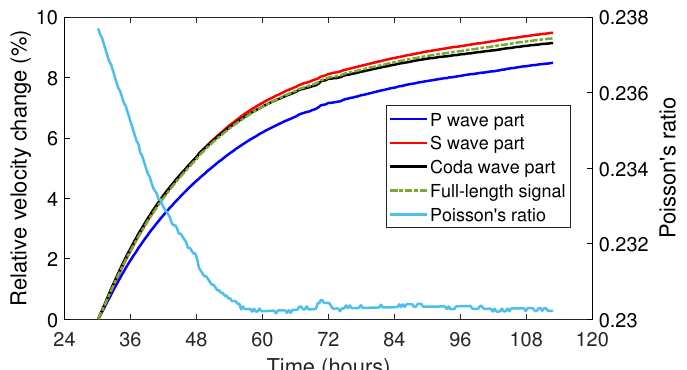
Figure 6. Relative wave velocity changes and Poisson’s ratio development calculated from different time windows. The reference signal was obtained at 30